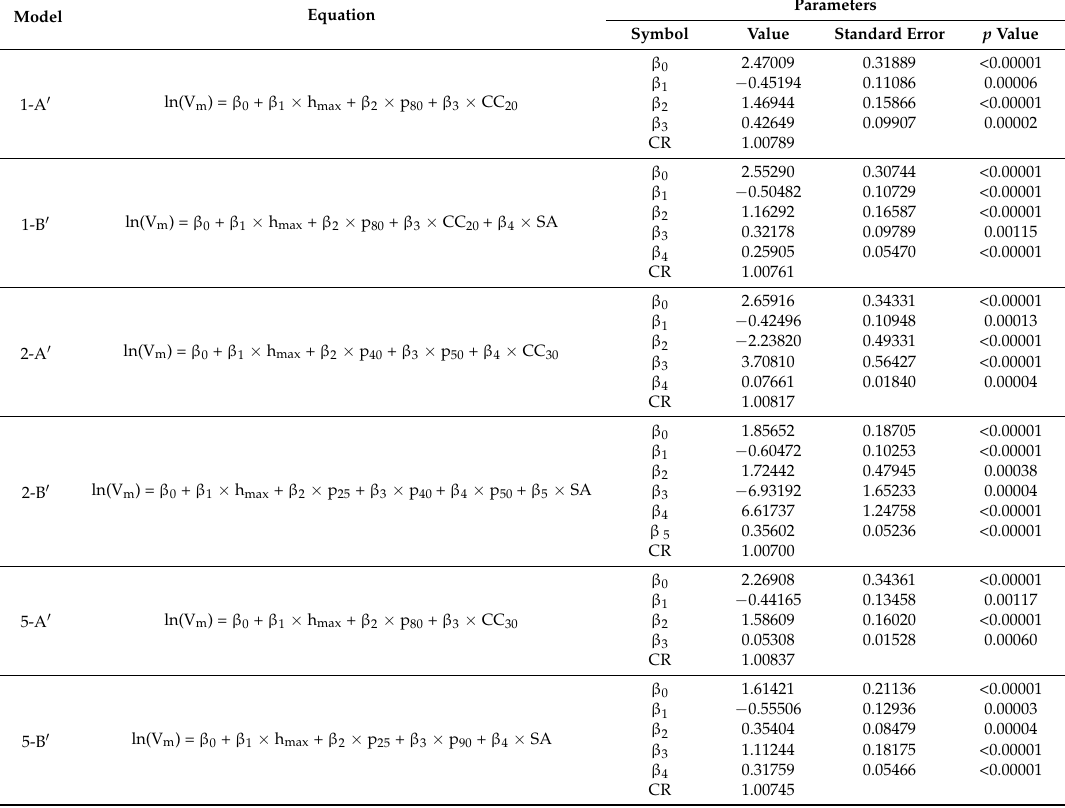
Table A4. Description (selected independent variables, estimated parameters, standard errors and significance values) of six selected stand-level volume models (double-log models, i.e., models with the logarithmically transformed dependent and independent variables), including Snowdon’s correction ratio (CR) for bias correction (Equations (2) and (3)). Two models were selected for each CHM resolution which the model was developed, whereas letter denotes whether the model was derived solely from CHM metrics as independent variables (A (cid:48) ), or from both CHM metrics and FMP variables (B (cid:48)